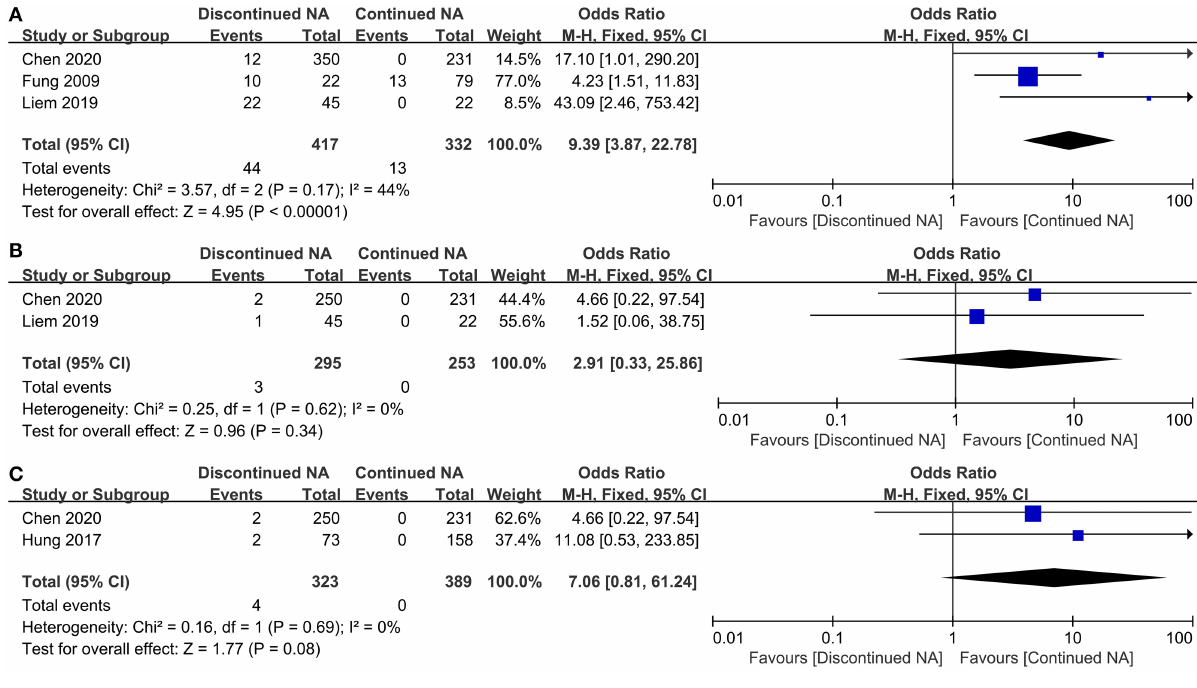
FIGURE 2 | Forest plot on biochemical outcomes comparing between continued Nucs therapy and discontinued Nucs therapy. (A) ALT flares-up; (B) hyperbilirubinaemia level; (C) hepatic